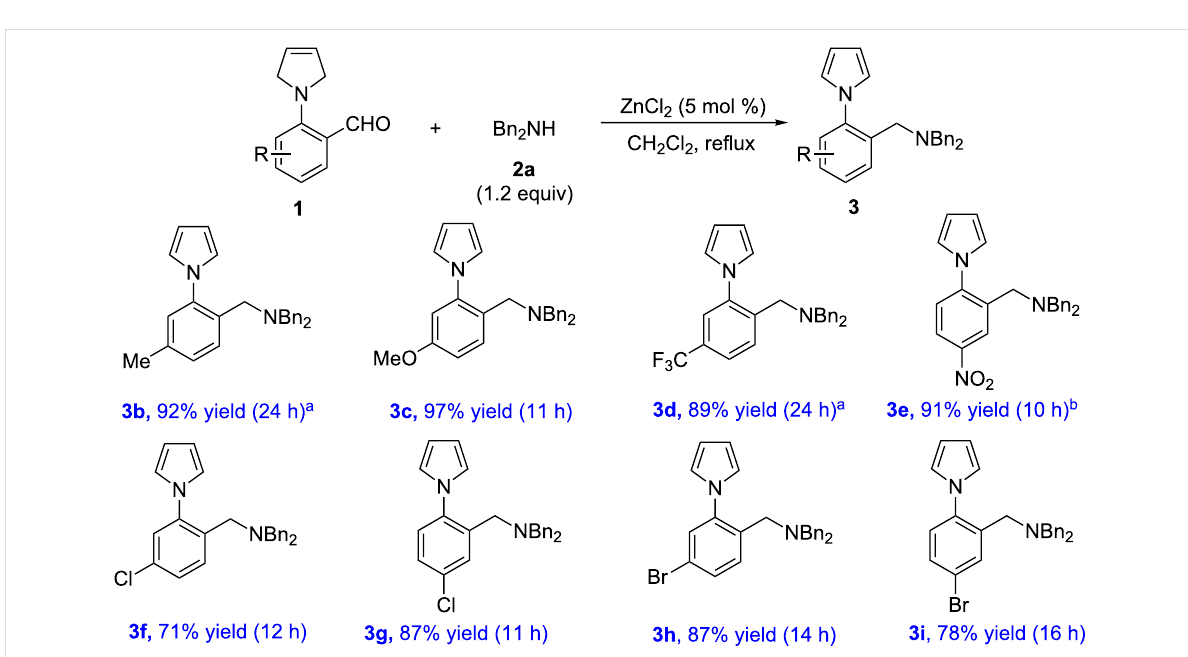
Scheme 2: Substrate scope of aryl aldehydes 1 . Reagents and conditions: 1 (0.3 mmol), 2a (1.2 equiv), ZnCl 2 (5 mol %), CH 2 Cl 2 (3.0 mL). a Room temperature. b DCE,